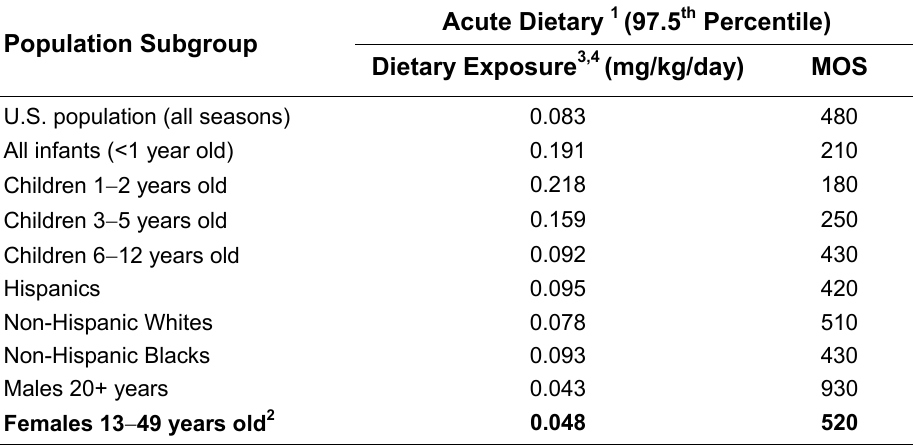
Summary of Theoretical Dietary Exposure and Risk for Resmethrin Acute Dietary 1 (97.5 th Percentile) Population Subgroup Dietary Exposure 3,4 (mg/kg/day)